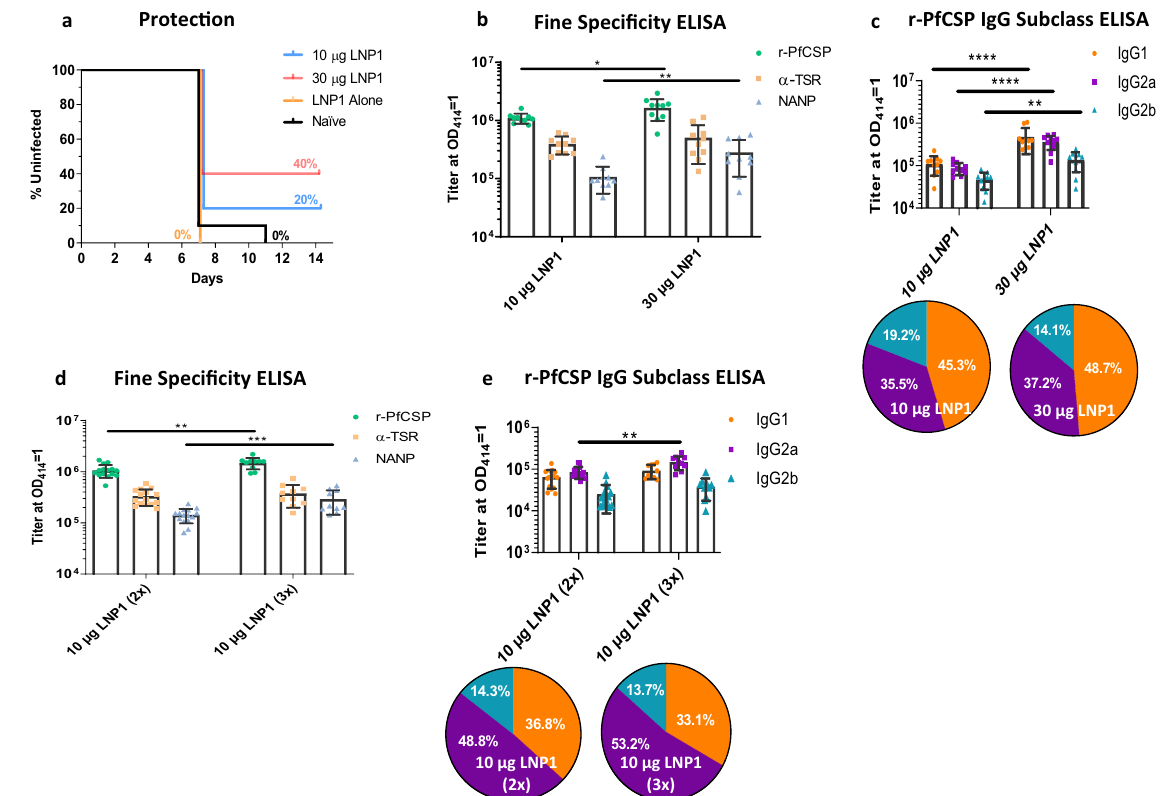
Fig. 2 PfCSP mRNA-LNP1 elicits a dose-dependent response in BALB/c. A 10 µg and 30 µg dose PfCSP mRNA-LNP1 (TriLink) prime:boost regimen at a 3-week interval was tested in a Pb(ANKA)-PfCSP (NF54/3D7) transgenic challenge experiment ( N = 10 per group) with 1000 sporozoites injected intravenously. a Kaplan – Meier survival curves report the percent survival of infected mice. Ef fi cacy was calculated against the negative controls (LNP1 alone and naïve controls). Survival was de fi ned as mice without detectable parasitemia by thin blood smear by day 14. b Fine speci fi city ELISAs were performed to quantify IgG responses to the r-PfCSP protein, the (NANP) 6 repeat region, and the α -TSR domain peptides. Data are reported as the GM with 95% CI. c To capture the IgG subclasses elicited by PfCSP mRNA-LNP1, r-PfCSP ELISAs were performed and IgG1, IgG2a, and IgG2b OD 1.0 titers reported. Data in the bar graph are reported as the GM with 95% CI. Pie charts are representative of the relative response of each subclass. To assess the in fl uence of an additional booster dose in a 3-week immunization regimen, mice were immunized in a prime:boost (2x) ( N = 15 per group) and prime:boost:boost (3x) regimen ( N = 10 per group). IgG was quanti fi ed for d r-PfCSP, α -TSR domain, (NANP) 6 repeat peptide and e IgG subclass. All statistical analyses were performed using a Mann Whitney test (* p < 0.05; ** p < 0.01; *** p < 0.001; **** p < experiments were performed (Supplementary Fig. 5). The dose range (300, 1000, and 3000 sporozoites) was selected based on data reported from a wild-type P. berghei ANKA strain 33 . All mice across three independent experiments became infected at all doses, demonstrating overlapping, reproducible and high levels of infectivity. Having established the relative infectivity in the animal model, a challenge experiment was initiated. In this PfCSP mRNA-LNP1 protection study, a 30 µg dose, 10 µg dose, and LNP1 alone group were immunized twice with a 3-week interval ( N = 10). Two weeks following the fi nal immunization, blood samples were collected for antibody analyses. The challenge was performed by intrave- nous inoculation of 1000 Pb-PfCSP NF54/3D7 sporozoites. Mice were tested for blood-stage parasitemia by Giemsa stained thin blood smears on days 7, 8, 10, 11, and 14-post challenge. The kinetics of parasitemia detection are shown using Kaplan – Meier survival curves (Fig. 2a). Mice were sterile protected if no parasites were detected by day 14, the fi nal experiment day. Vaccine ef fi cacy of PfCSP mRNA-LNP1 was 40% for the high dose group and 20% for the low dose group, relative to unvaccinated challenge controls, which all developed a blood-stage infection. While no statistical differences were detected between the two dosage groups, the high dose group did achieve signi fi cance